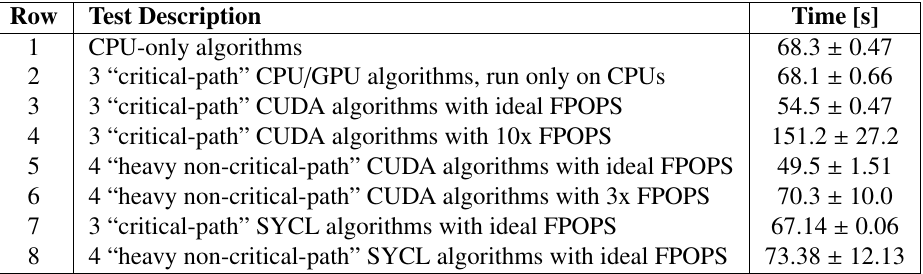
Table 1. CUDA and SYCL (oneAPI) performance results Row Test